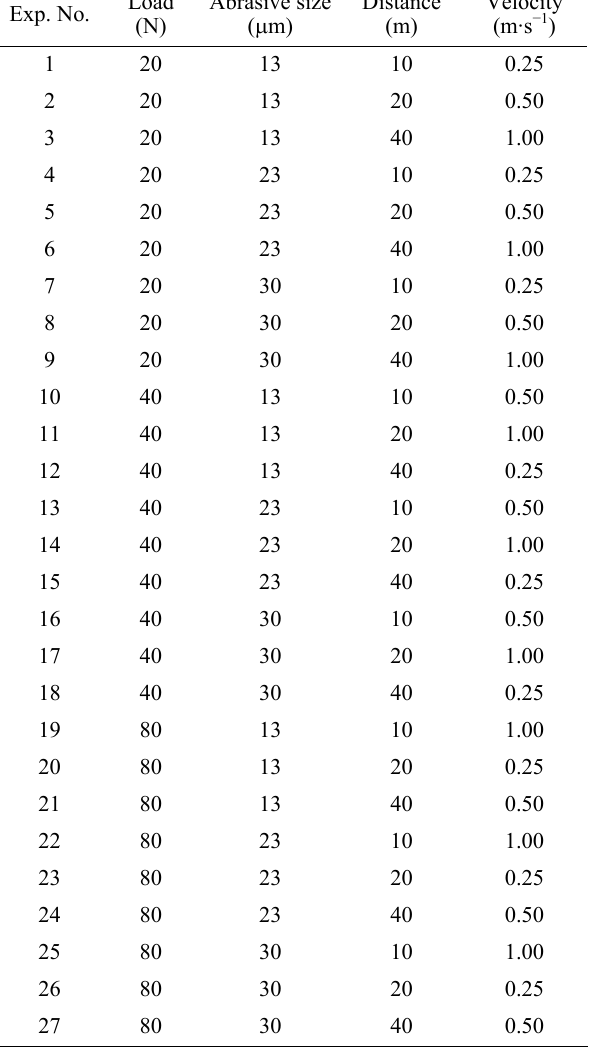
Table 2 Experimental layout following Taguchi L 27 orthogonal